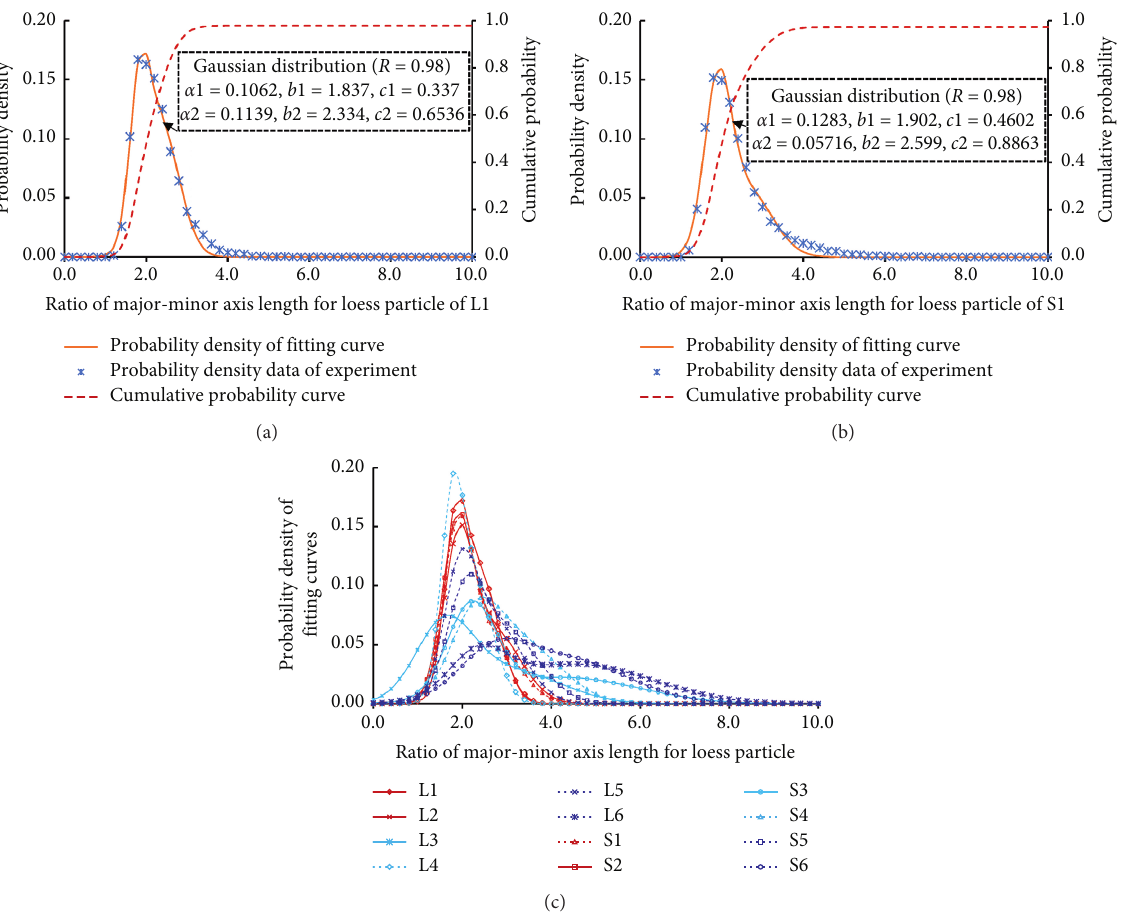
Figure 6: Distribution characteristics of the major-minor axis ratio of loess particles: (a) L1; (b) S1; (c) variation in fitting curves for various layers of loess and paleosol.